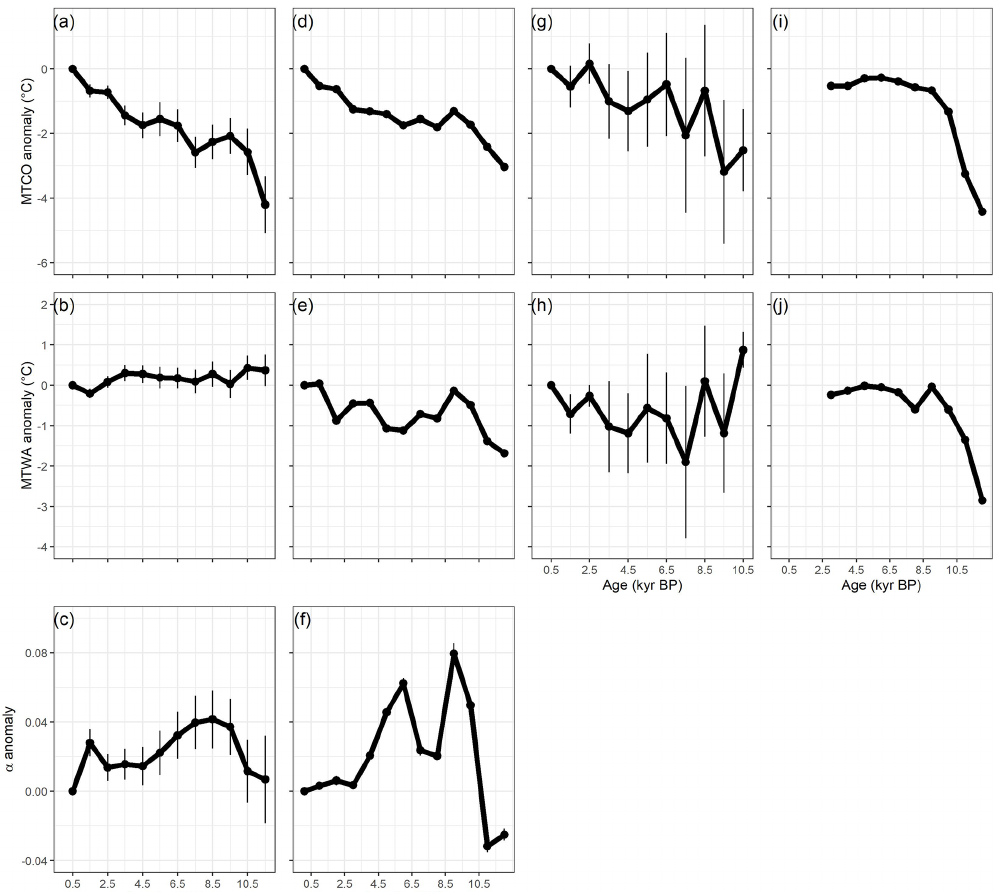
Figure 7. Comparison between reconstructed composite changes in climate anomalies. The first column represents this paper, the second column represents Mauri et al. (2015), the third column represents Kaufman et al. (2020) and the fourth column represents Tarroso et al. (2016). The composite curves from this paper and Kaufman et al. (2020) are calculated from individual reconstructions, using anomalies to 0.5ka and a bin of ± 500 years (time slices are 0.5, 1.5, ..., 11.5ka). The composite curves from Mauri et al. (2015) are converted directly from the gridded time slices which are provided with anomalies to 0.1ka and a bin of ± 500 years (time slices are 1, 2, ..., 12ka). The composite curves from Tarroso et al. (2016) are also converted directly from the gridded time slices provided, with anomalies to 0.5ka and a bin of ± 500 years (time slices are 3, 4, ..., 12ka). Note that Tarroso et al. (2016) applied a smoothing to the data such that the plots in their paper do not show the excursion in MTWA at 8ka. In all of the plots, the black lines show mean values across sites, with vertical line bars showing the standard deviation of mean values using 1000 bootstrap cycles of site/grid